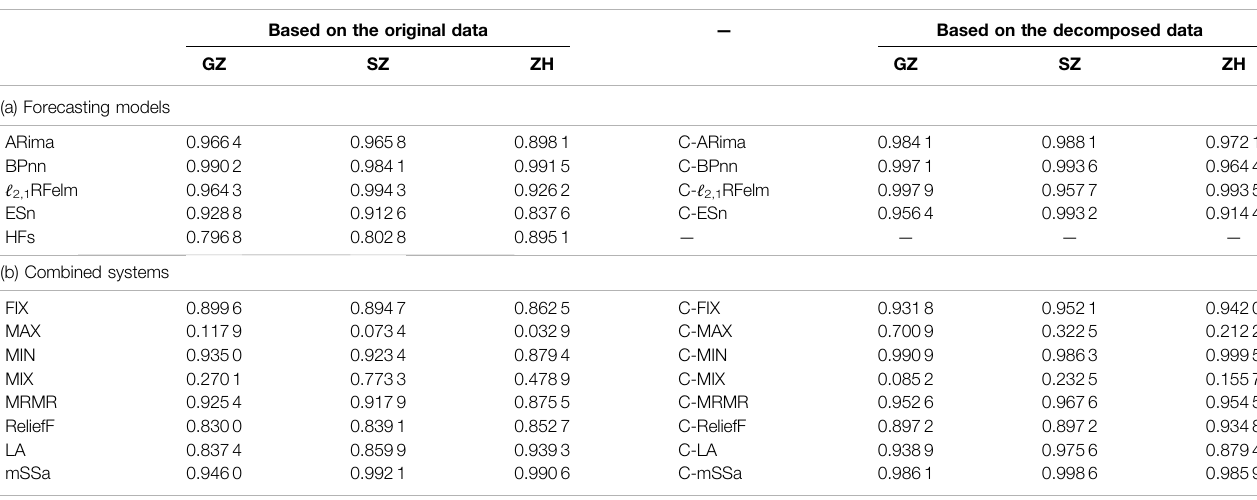
TABLE 8 | Results of the model stability test. Based on the original data — Based on the decomposed data